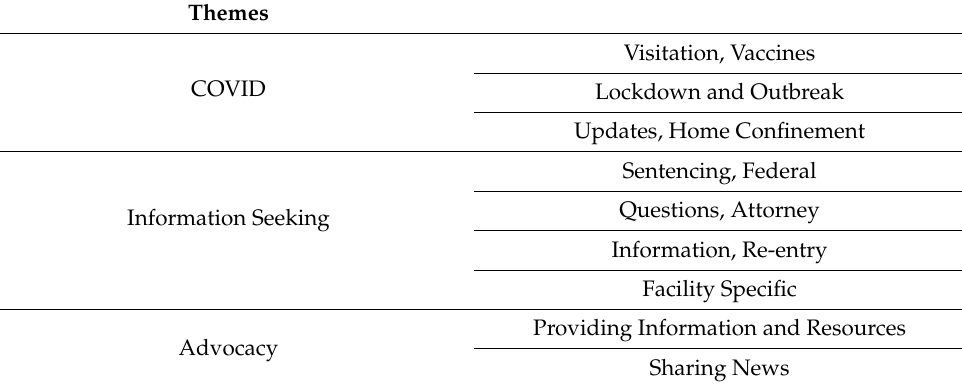
Table 1. Codes and